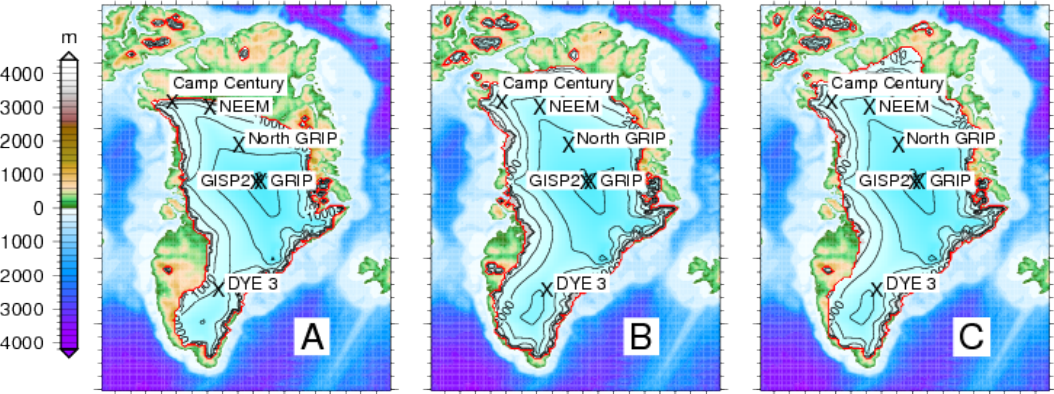
Fig. 7. Simulated GIS at 121 ka BP for: (A) No-anomaly experiment; (B) CNRM anomaly experiment; and (C) IPSL anomaly experiment. Deep ice cores are located on the map. Contour spacing is 500 m. The ice sheet margin is represented by the red contour.